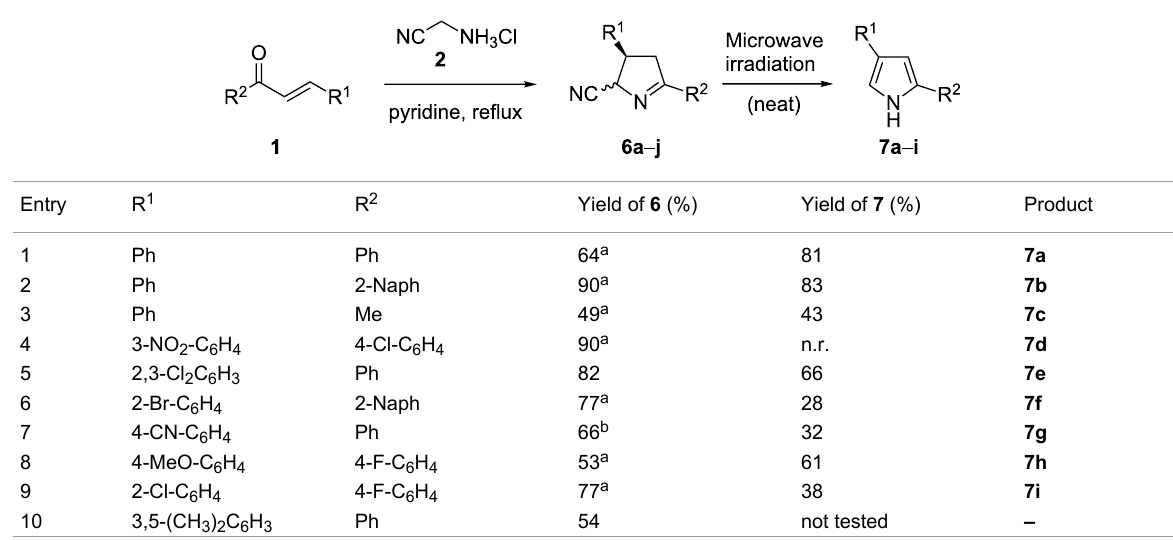
Table 1: Microwave-assisted synthesis of 2,4-disubstituted pyrroles 7a – i